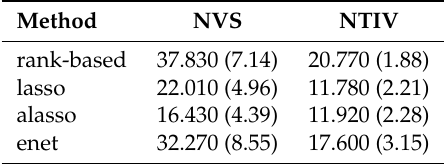
Table 7. Estimated mean and standard deviation of number of variables (NVS) selected and the number of true important variables (NTIV) among NVS in four different models under simulation scenario 3 with 150 replications. The values in parentheseses are standard deviations.